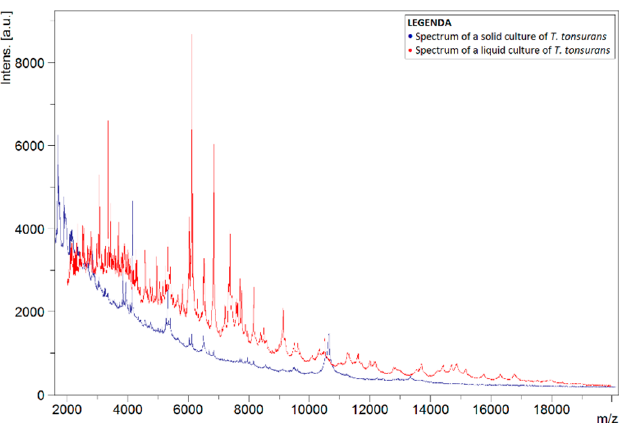
Figure 1. Spectra of liquid T. tonsurans isolate (red) and a solid T. tonsurans reference strain from the BCCM/IHEM collection (blue). Spectra show the signal intensity (Intens., in absorption units) of the ions detected by MALDI-TOF MS, as a function of their mass-to-charge ratio ( m / z , in kg/C).